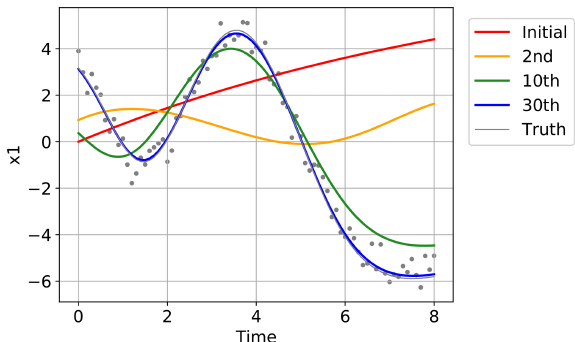
Figure 5. The temporal evolution started at the initial guess (red line), and the estimated evolutions after the second (yellow line), 10th (green line), and 30th iterations (blue line) in one of the 20 trials in Fig. 4. The truth is indicated with the gray line, and the time series of the synthetic observations used in this experiment are overplotted with gray